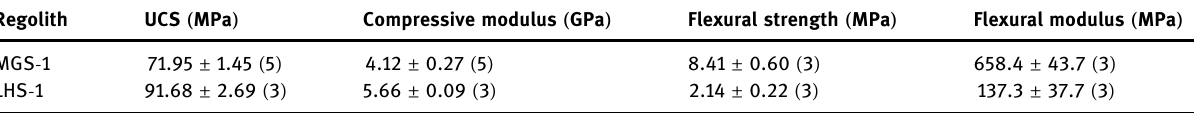
Table 3: Summary of the mechanical property data of MGS - 1 - and LHS - 1 - based Starcrete following optimisation Regolith UCS ( MPa